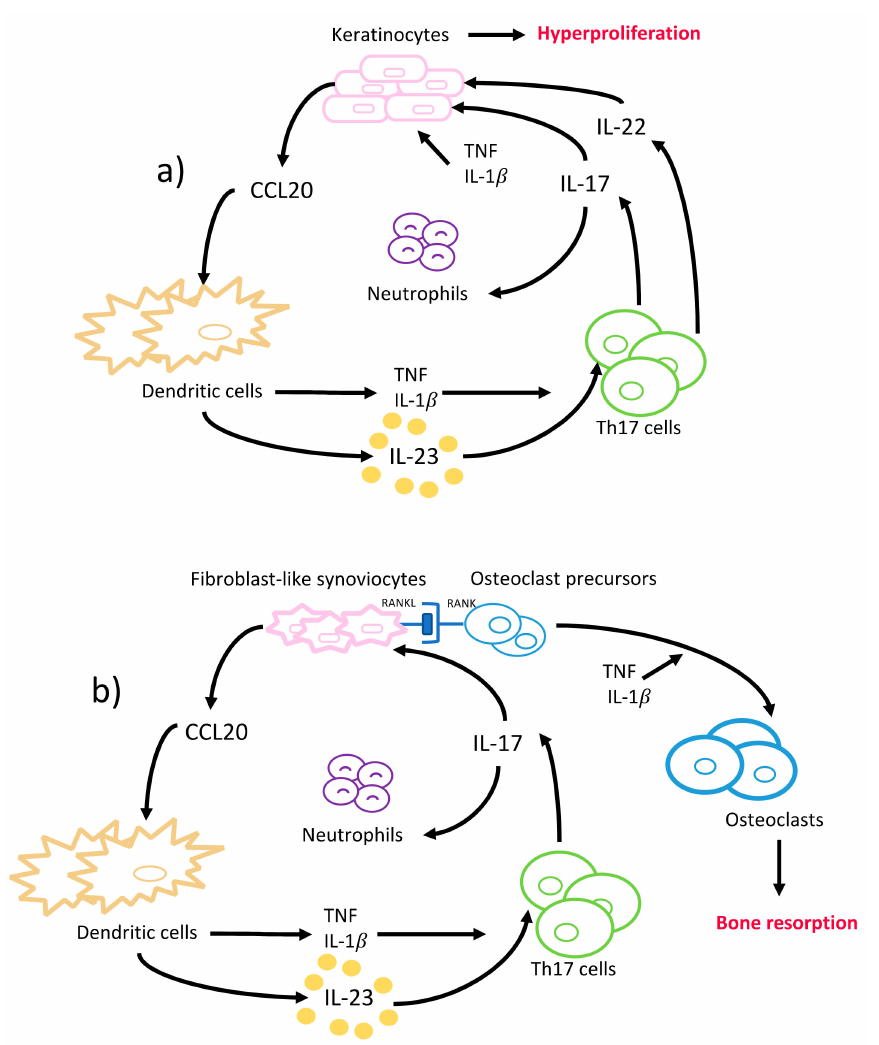
Figure 3. A simplified model of Th17 cells and the cytokines involved in the pathogenesis of ( a ) psoriasis and ( b ) rheumatoid arthritis. This figure can also be interpreted as a model of pathogenesis ofgingival, periodontal, andoralmucosalinflammatorydiseases, wherecellssuchasgingivalfibroblasts, keratinocytes, and epithelial cells are